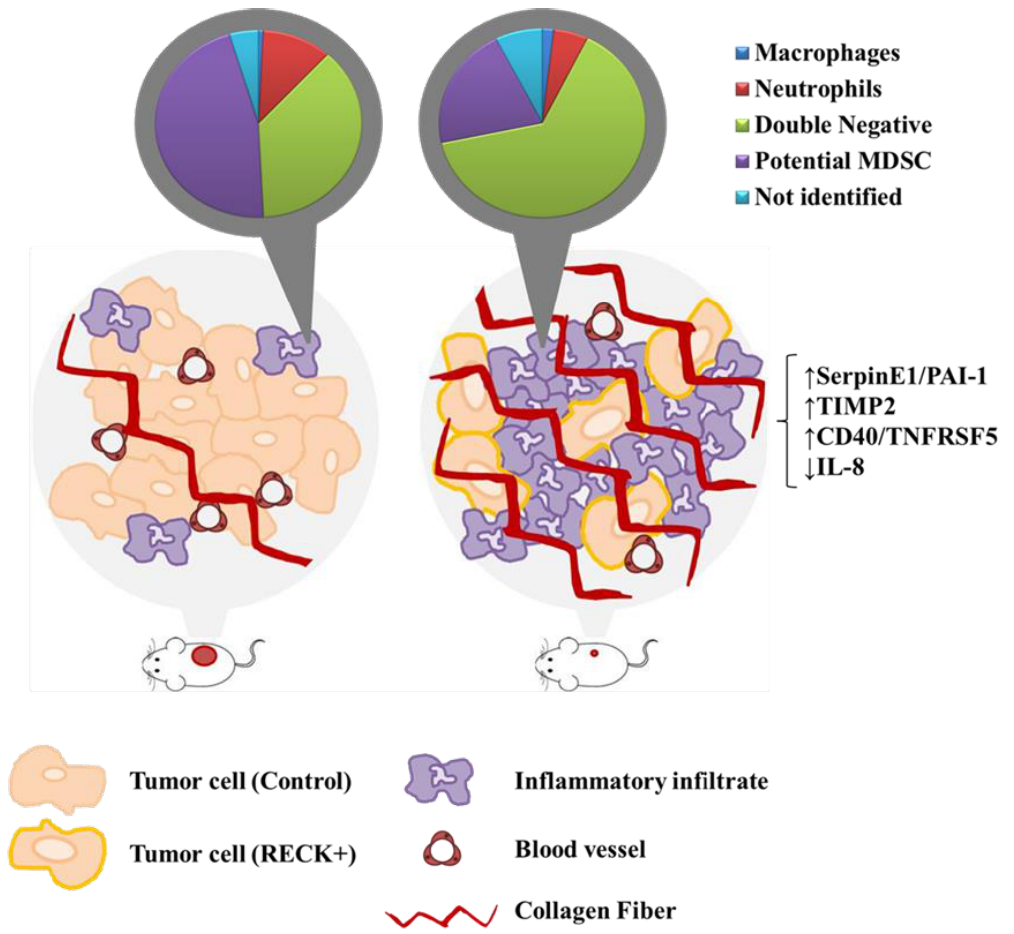
Figure 8. Proposed global effects of RECK expression in a cervical cancer model. Animals s.c. injected with cervical cancer derived cells transduced to over express RECK present delayed establishment and reduced tumor volume when compared to control. RECK over expressing cells are represented with light orange cell membrane and the red circles in mice lateral side represent the induced tumors. RECK+ tumors also showed reduced proportion of tumor and endothelial cells, the latter was depicted here in dark red blood vessels. Moreover, we observed specific increased proportion of Double negative inflammatory infiltrate (pie charts in the top) and higher collagen content (bright red linear structures) in RECK+ tumors. Finally, RECK over expression correlated with higher levels of SerpinE1/PAI-1, TIMP-2 and CD40/TNFRSF5 proteins, while presented an inverse correlation with IL-8 protein expression (on the far-right side).